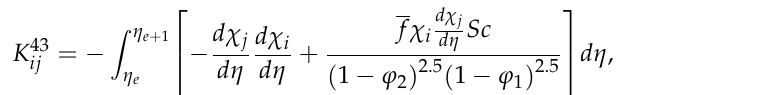
Table 3. Comparative study of a temperature gradient with published results of Qureshi et al. [45] in the case of nanofluid.